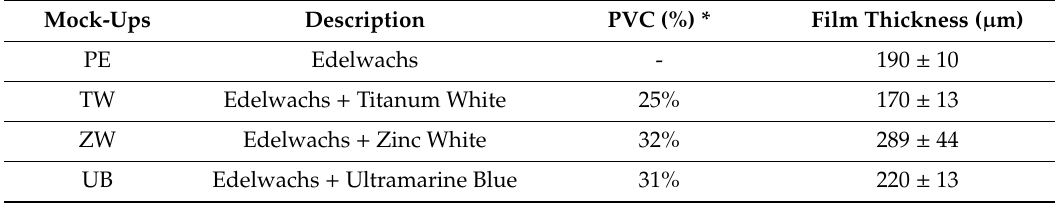
Table 1. List of mock-ups, description, pigment volume concentration (PVC) and dried film thickness. Mock-Ups Description PVC (%) *